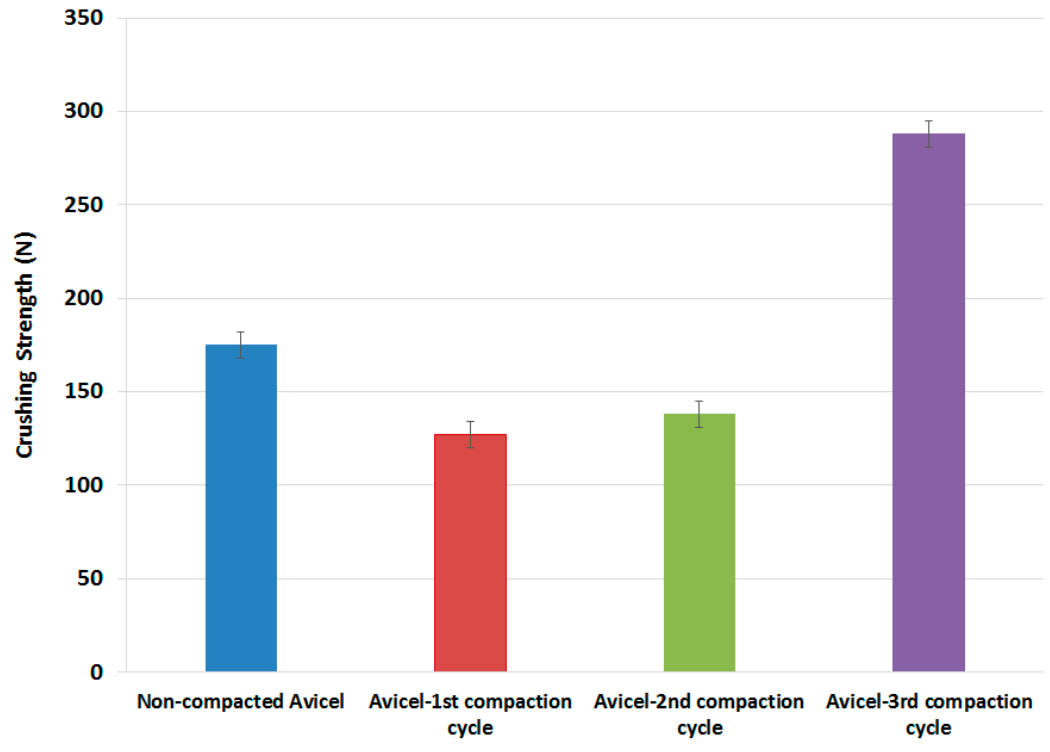
Figure 8. Tablet crushing strength as a function of compaction cycles.